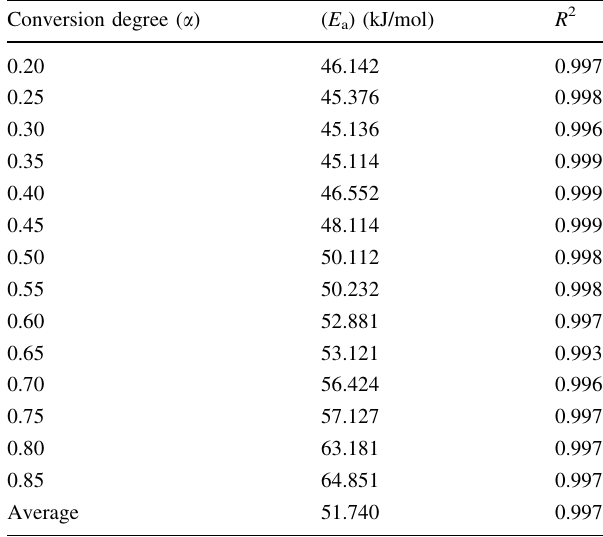
Table 5 Pyrolysis kinetic parameters of low rank coal Heating rate (K/